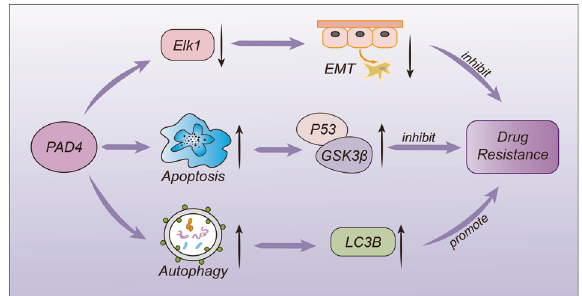
Fig. 12 The opposite roles of histone arginine demethylase PAD4 in drug resistance. PAD4 can not only inhibit the production of drug resistance through regulating EMT and apoptosis, but also promote autophagy and enhance drug